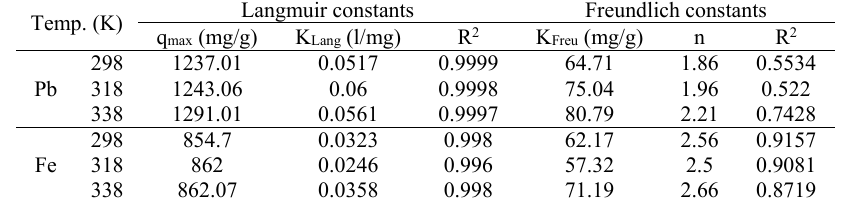
Table 3: Adsorption isotherm parameters for Pb 2+ and Fe 2+ ions using calcium carbonate nanoparticles at different temperatures